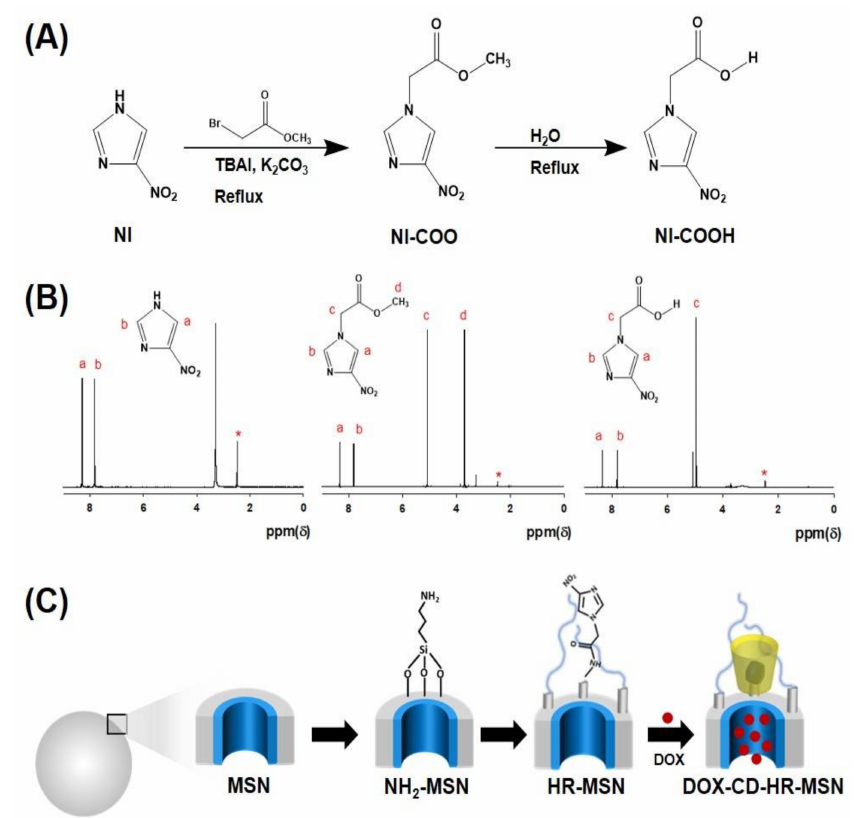
Figure 2. ( A ) Synthetic scheme of nitroimidazole (NI) derivatives; ( B ) 1 H-NMR spectra of NI derivatives in DMSO- D 6 ; ( C ) Synthetic illustration for formation of